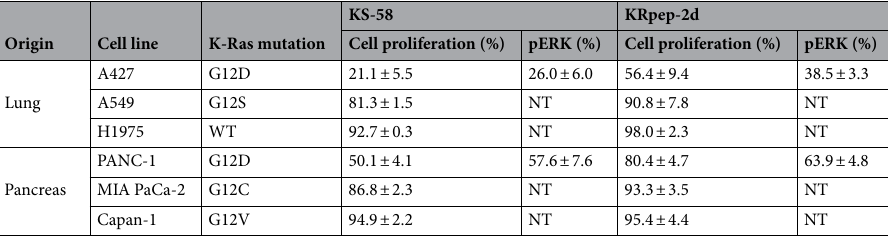
Table 2. Cell proliferation rate and phosphorylation rate of ERK in the presence of peptide. Peptide concentration was 30 µM (n = 4, ± SEM). NT means not